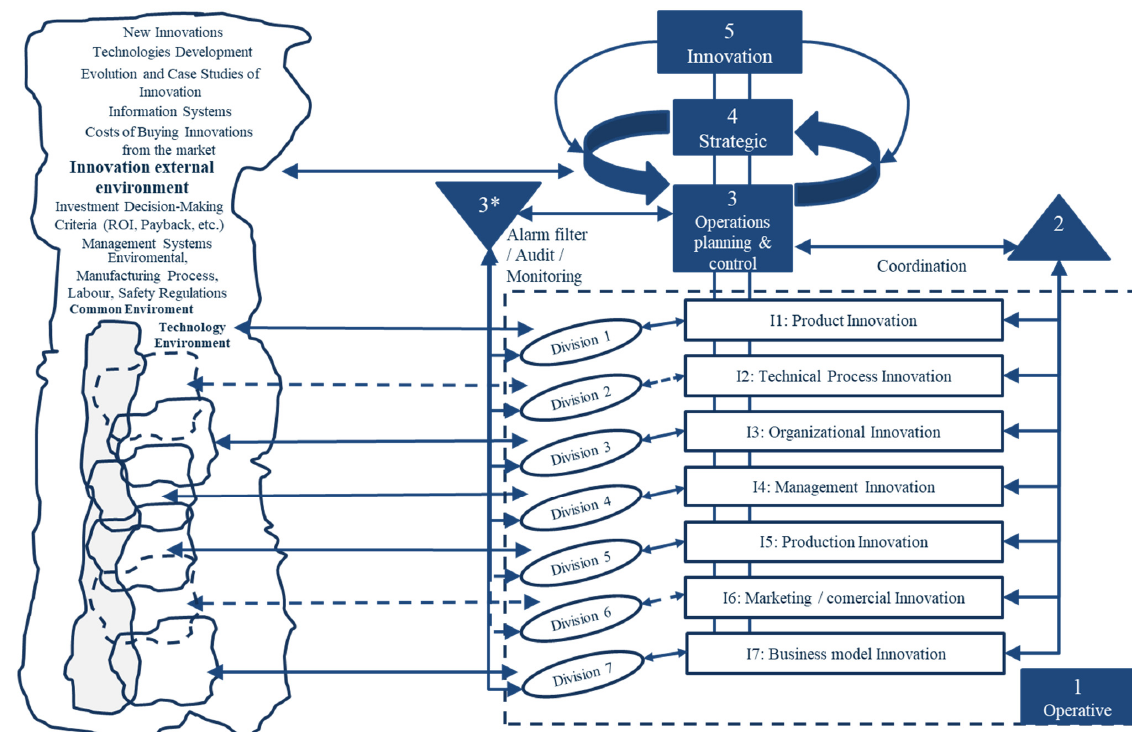
Figure 4. VSM analogy with innovation management (own elaboration).